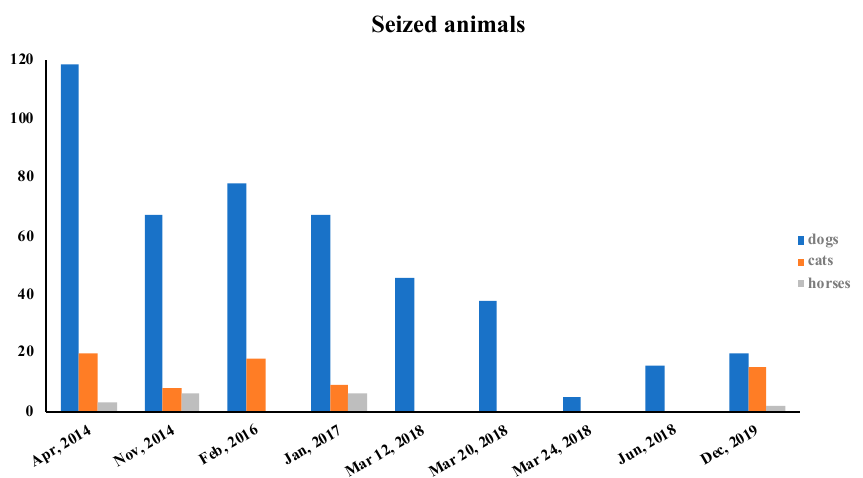
Figure 1. The graph represents the number of animals, divided according to species, subject to the various seizures carried out from April to December 2019.